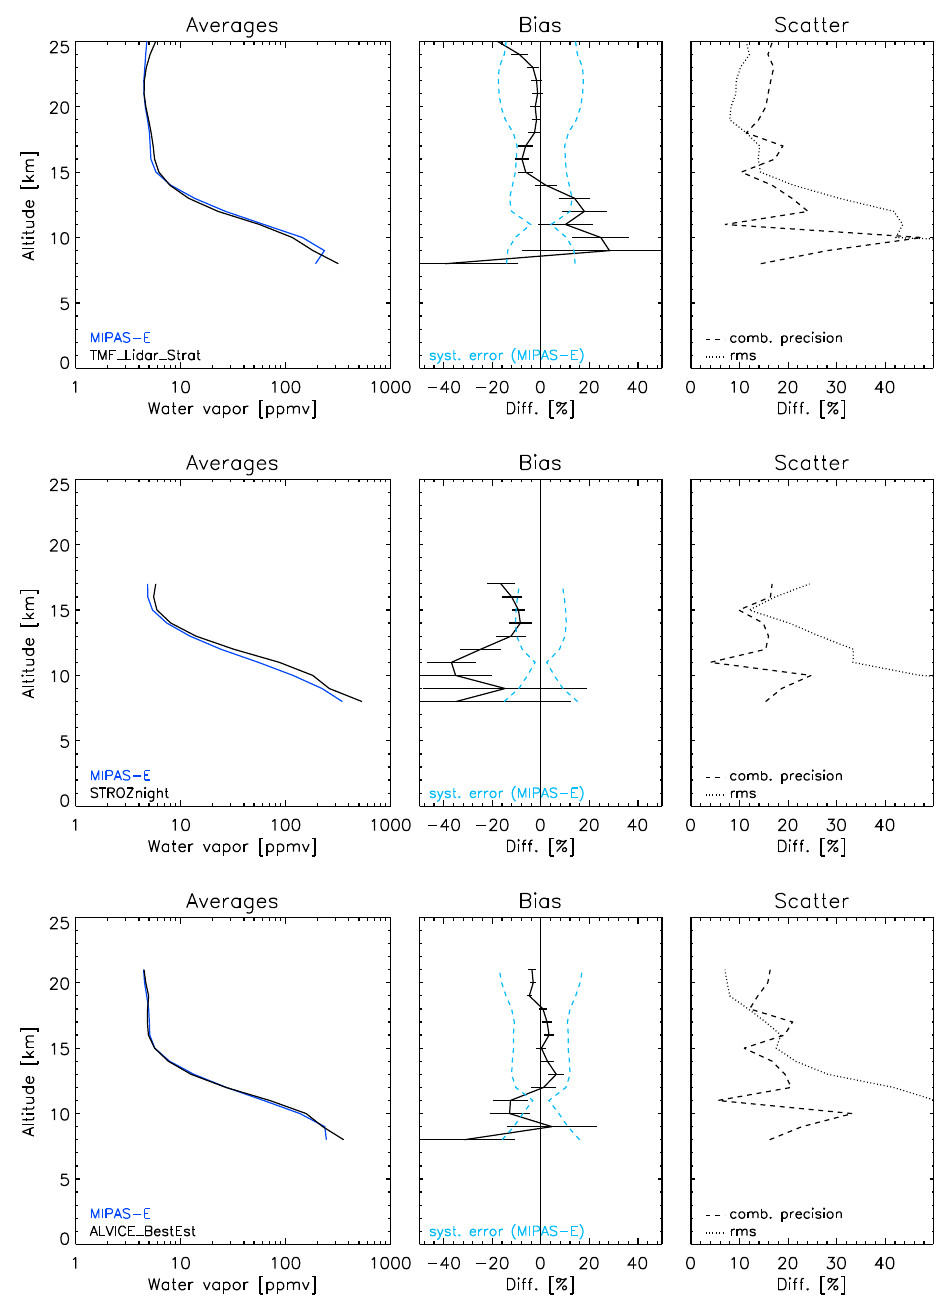
Fig. 9. Same as Fig. 2 but for water vapor profiles from TMW lidar (top row), STROZ lidar (middle row), and ALVICE lidar (bottom row); the absolute water vapor VMRs are presented on a logarithmic scale, while the bias and the various errors and bias-corrected rms differences are presented as percentage of the average reference profile. For a more detailed description see Fig. 2.